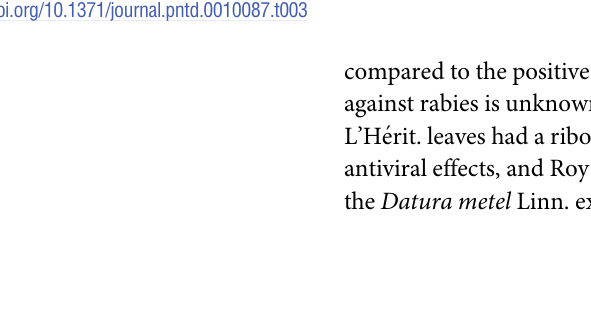
compared to the positive control group [37]. The possible acting ingredient of each extract against rabies is unknown, but Admasu et al. (2014) speculated that Phytolacca dodecandra L’He ´ rit. leaves had a ribosomal inhibiting protein (RIP) called dodecandrin that could have antiviral effects, and Roy et al. (2018) suspected an anticholinergic agent such as atropine in the Datura metel Linn. extract [35,37].